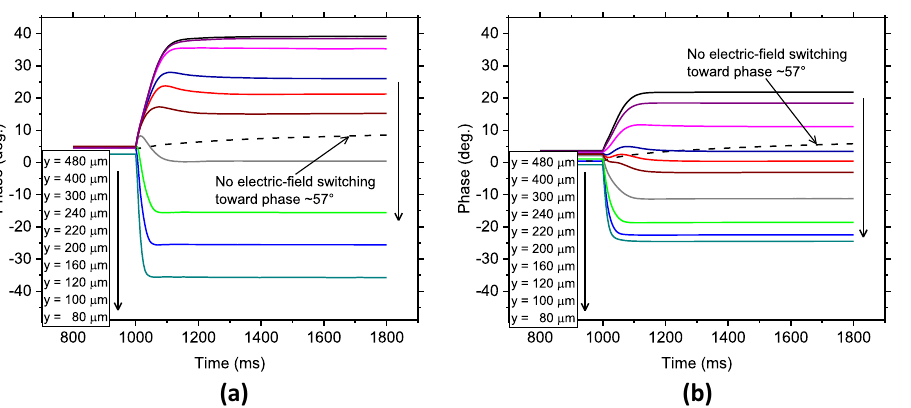
Figure 6. Dynamic phase changes calculated at 2 THz when each cell is switched from the out-of-plane state of 100 V to the in-plane state of 100 V for various values of y ; ( a ) Mean phase changes in the x – z cross-section at the centre of the y -axis. ( b ) Mean phase changes of the entire unit cell space. For the first 1000 ms, the out-plane state of 100 V was applied to each cell, and the potential was switched to the in-plane state of 100 V at 1000 ms. The dotted line shows the case without electric field switching in the cell with y = 100 μm, meaning switching only from the out-plane state of 100 V to